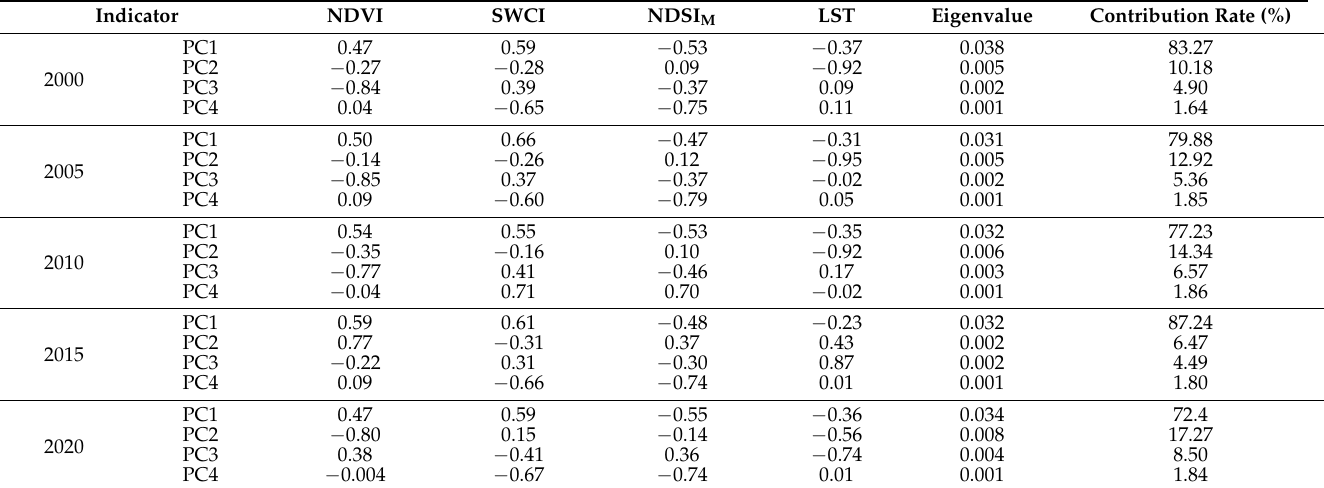
Table 2. Results of PCA for four indicators of RSEI in the YREBML during 2000–2020.